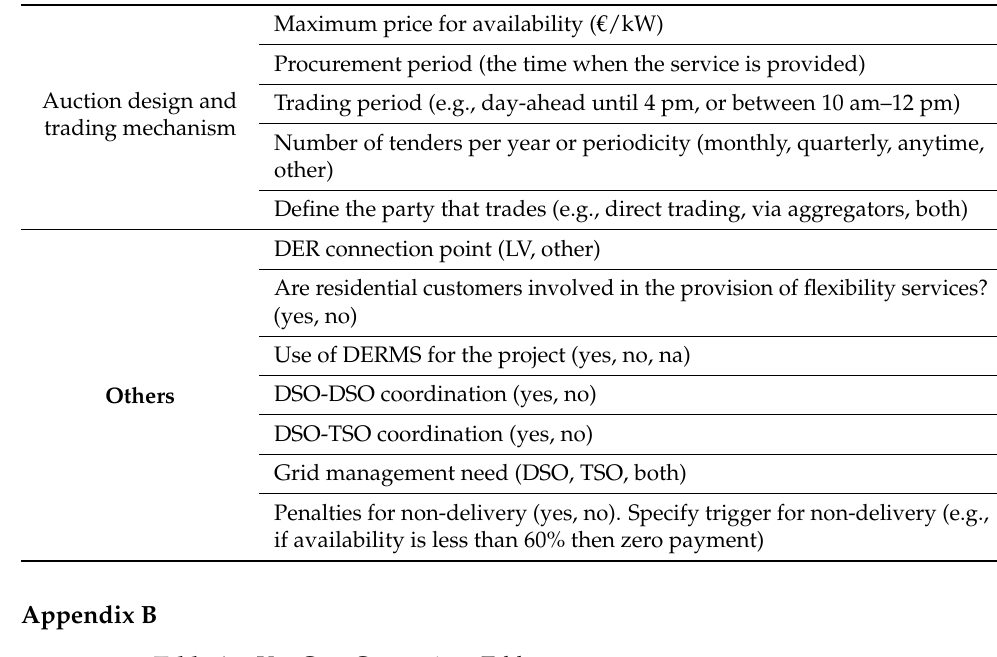
Table A2. Use Case Comparison